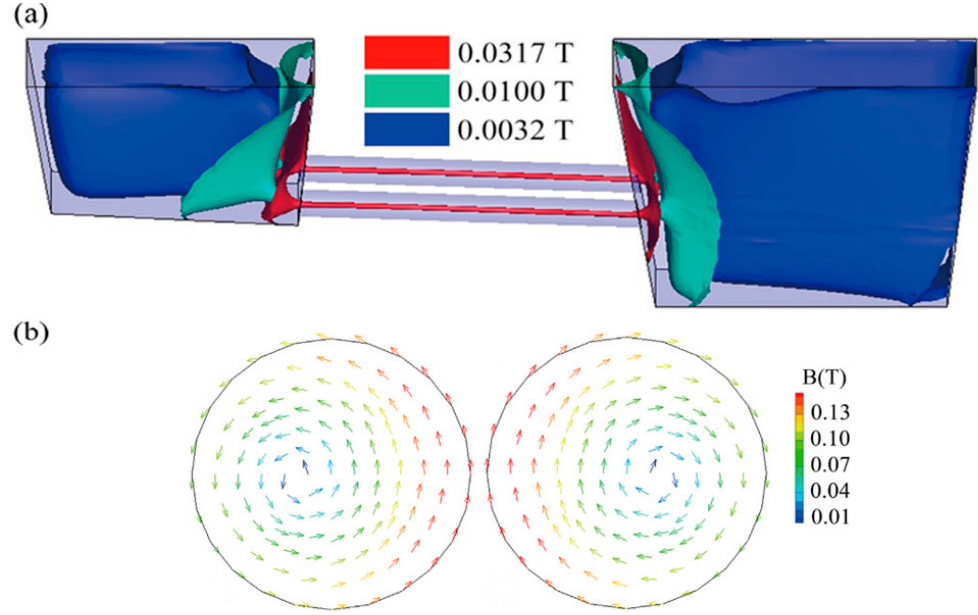
Figure 3. Distribution of magnetic field in the tundish [33]. ( a ) The effective area of the electromagnetic field in the chamber, ( b ) the vector of the magnetic flux density in the channels. The magnetic induction intensity and current density generated by molten steel in the channel increase linearly with the increase of the coil’s current intensity. With the increase in the current frequency, the induced current density on the channel surface and Joule heating generated by molten steel increase continuously, while the magnetic induction intensity and electromagnetic force